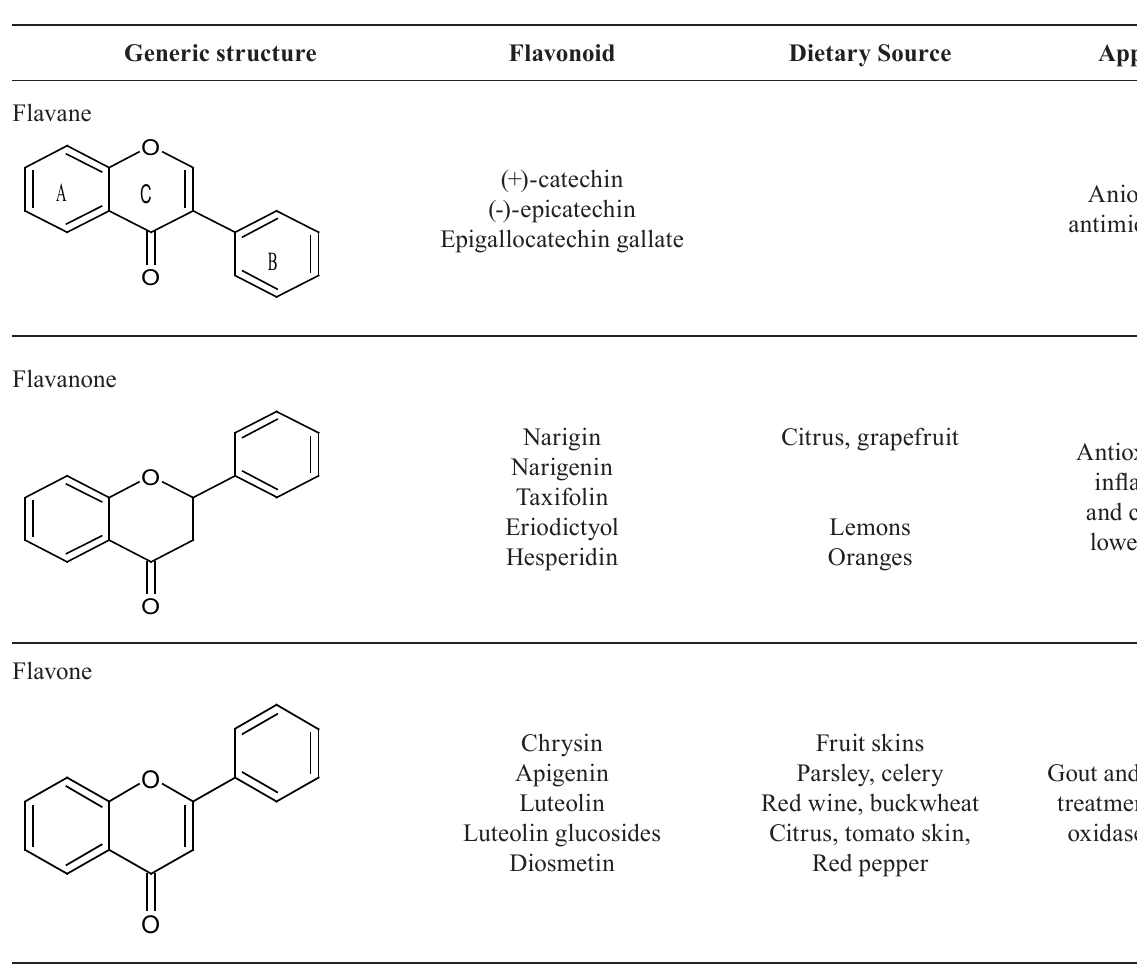
TABLE I - Classification of flavonoids, their chemical constituents and sources (Panche et al. 2016); (Ugazio et al . 2016)